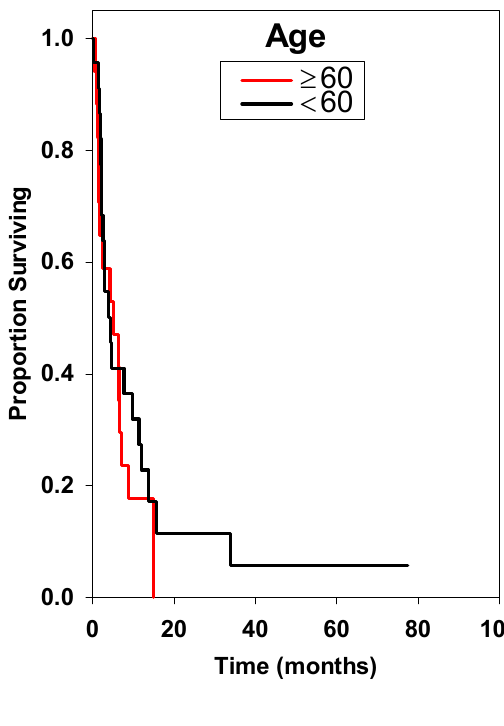
Figure 3. Survival curves based on